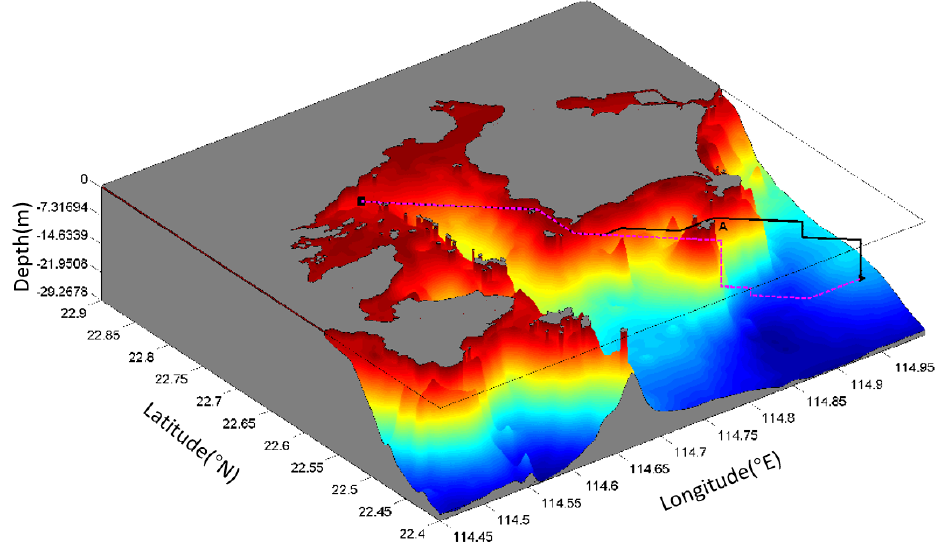
Figure 10. The optimal path predicted by the 3D-MDP algorithm with (black solid) and without (magenta dash) consideration to the 3D ocean currents.